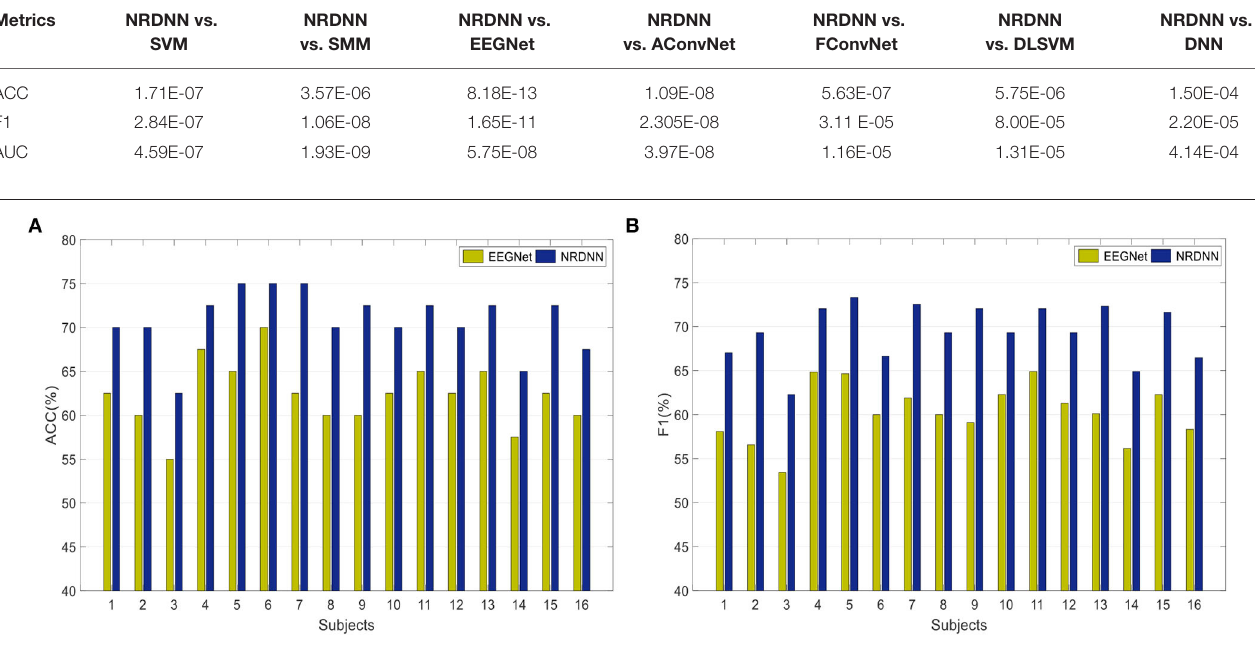
FIGURE 4 | Classification results of both EEGNet and the proposed framework NRDNN using EEGNet as its network backbone. (A) Classification performance (ACC), and (B) Classification performance (F1).